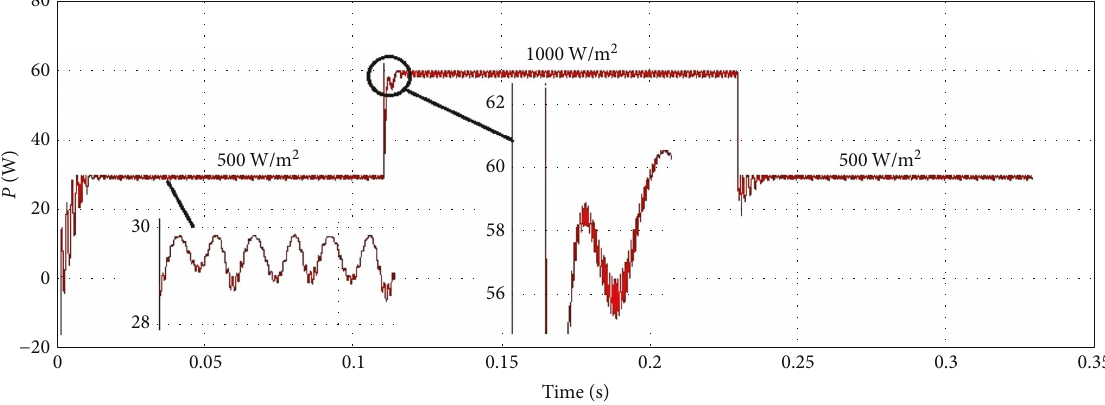
Figure 22: Test result of the INC algorithm.